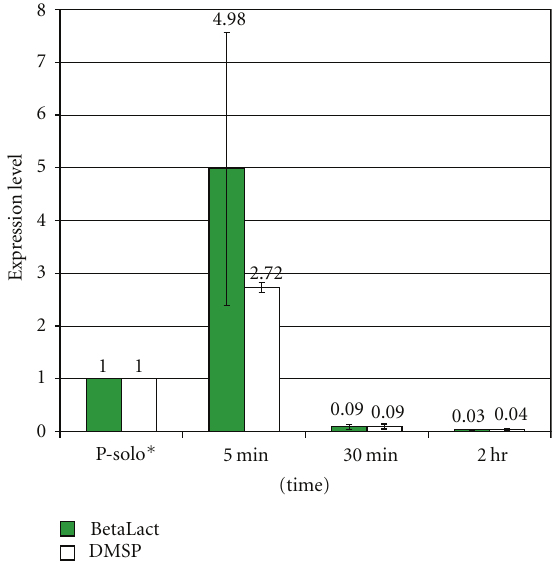
Figure 3: R. denitrificans BetaLact and DMSP relative gene expression in R. denitrificans-S. arenicola dual co-culture. Methods were as described in Figure